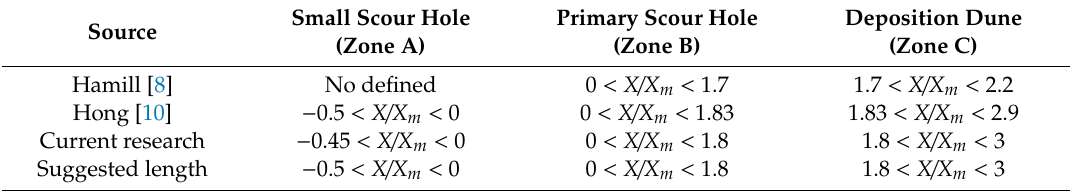
Table 4. Dimensionless length of each zone for single-propeller induced